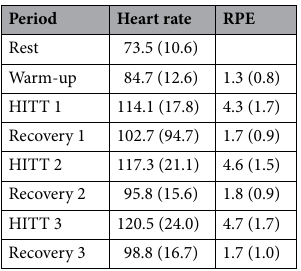
Table 2. Mean heart rate and rate of perceived exertion (SD) averaged across the 5-day intervention for the exercise